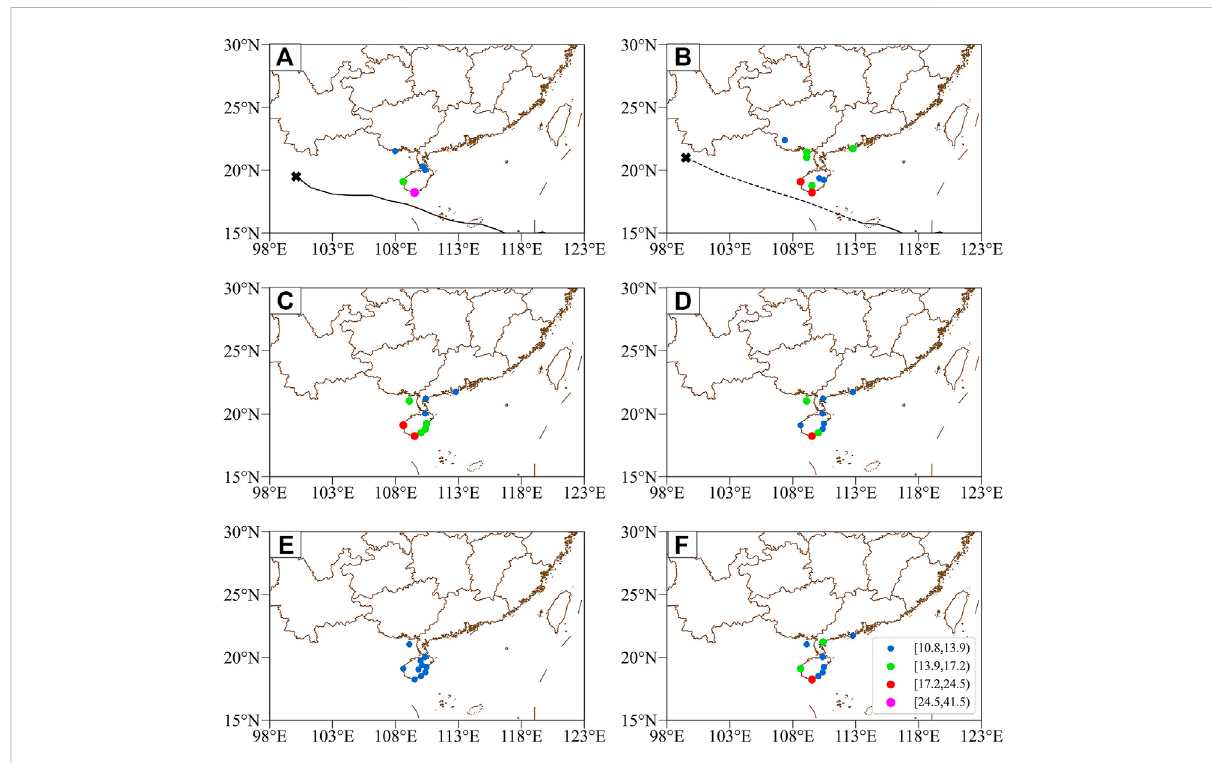
FIGURE 11 Spatial distributions of the potential maximum gale (m/s) associated with Doksuri according to (A) observations, (B) the DSAEF_LTG model, (C) CMA, (D) ECMWF, (E) JMA, and (F) NCEP. The observed and forecasted tracks are also plotted (black line and black dotted line, respectively). The marker “ × ” represents the end of the TC